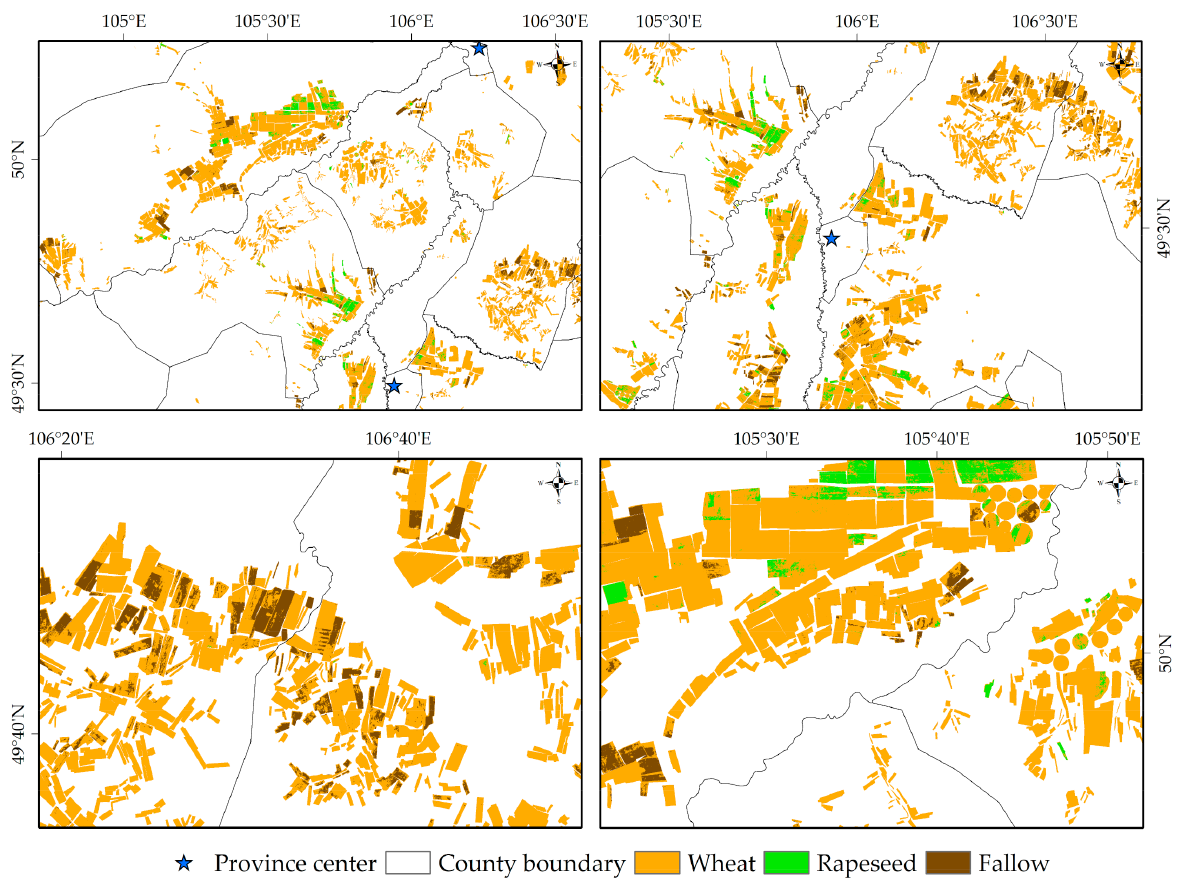
Figure 11. The detail of crop-type distribution in Selenge and Darkhan provinces of